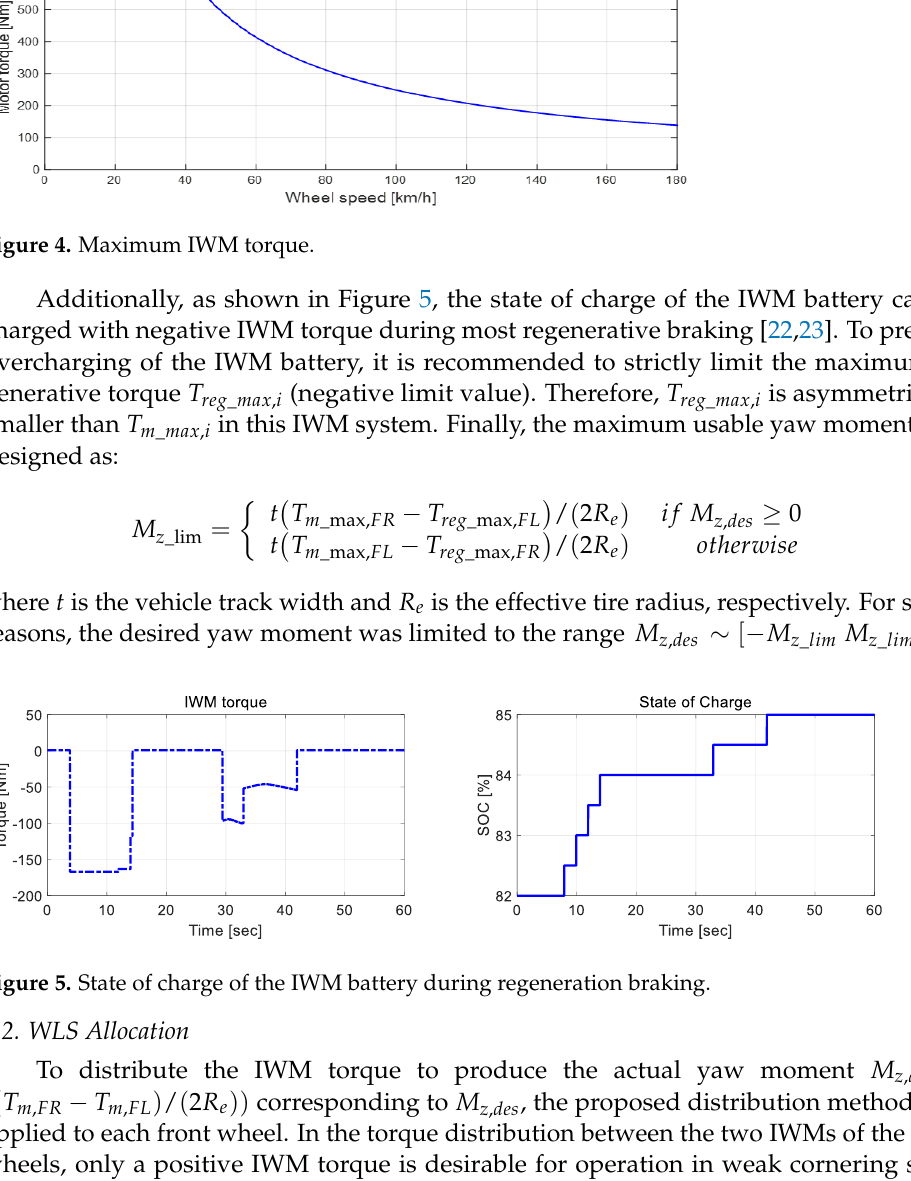
Figure 5. State of charge of the IWM battery during regeneration braking.